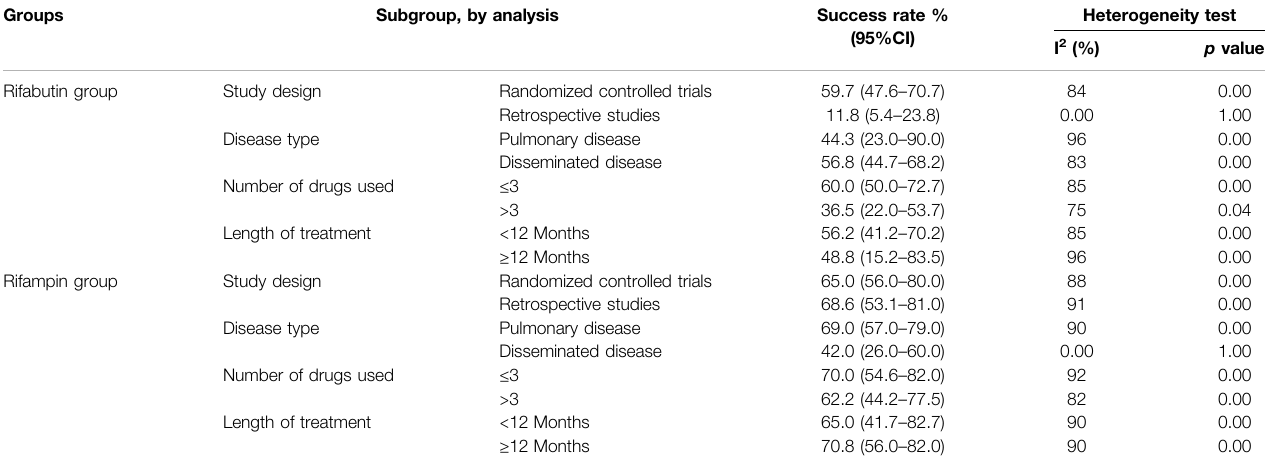
TABLE 3 | Pooled treatment success rate among subgroups of studies. Groups Subgroup, by